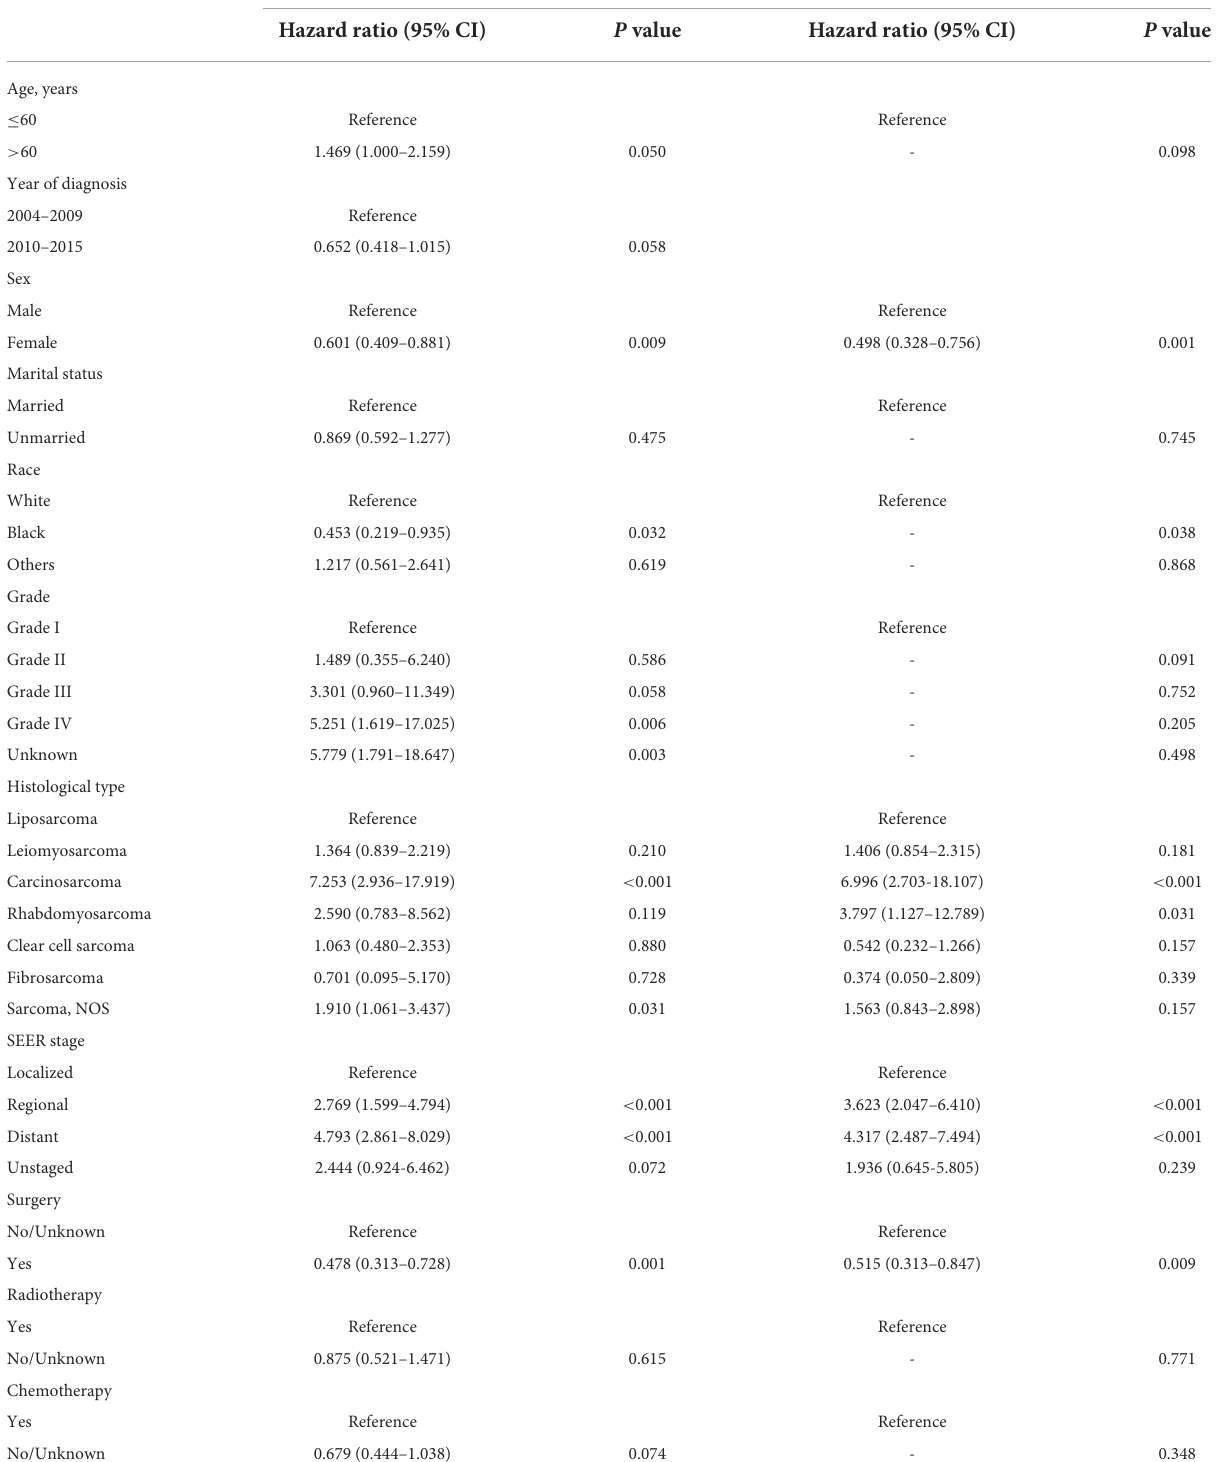
TABLE 2 Univariate and multivariate analysis of overall survival (OS) rates in the training cohort. Characteristic Univariate